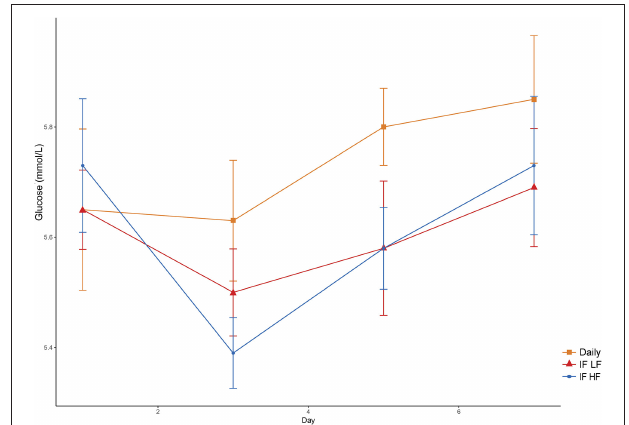
FIGURE 7 | Mean concentrations ( ± SE) of fasted plasma glucose in 10 dogs fed daily (square), and intermittently fasted on a low fat (triangle) and a high fat diet (circle) in a Latin Square design.